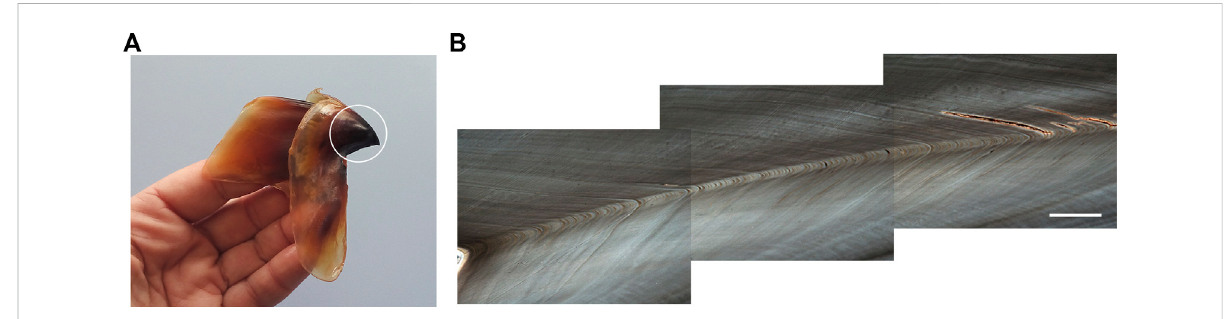
FIGURE 5 Lower beak of the giant squid Architeuthis dux . A white circle highlights the rostrum (A) . Image composition of the sagittal section of the lower beak rostrum showing growth increments (B) . From Perales-Raya et al. (2020); copyright permission obtained). Bar: 200